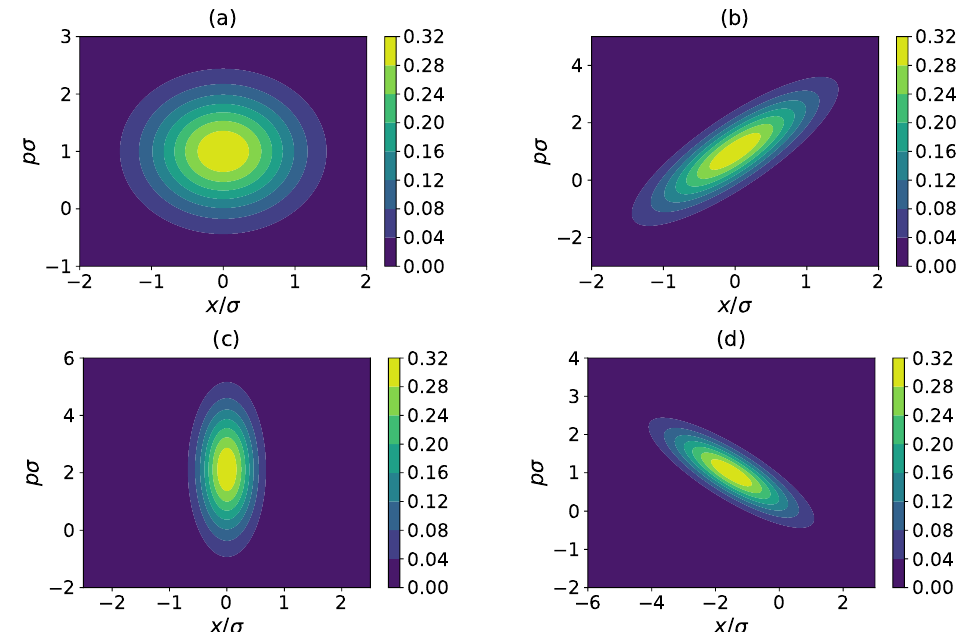
Figure 1: Contour plots of different Wigner functions. Panel (a) shows the Wigner function W ( x , p ) for a Gaussian wave packet, see Eq. (18). In the x and p direction, W ( x , p ) is a Gaussian centered around the phase space point ( a , k ) with variance σ 2 / 2 and ( 2 σ 2 ) − 1 , respectively. We chose a = 0, k = 1, and σ = 1. Panel (b) shows the Wigner function W + ( x , p ) for the wave function | ψ + 〉 ≡ exp ( ξ + ˆ S + ) | ψ 〉 , see Eq. (82). This transformation shifts the p variable by an x -dependent linear term, i.e., p → p − x Im ( ξ + ) ; here we choose ξ + = 1.5 i . Panel (c) shows the Wigner ( x , p ) for the wave function | ψ 〉 ≡ exp ( ξ z ˆ S z ) | ψ 〉 , see Eq. (77). This function W z transformation uniformly rescales the variables ( x , p ) to ( x e ξ z / 2 , p e − ξ z / 2 ) ; here we chose ξ z = 1.5. Panel (d) shows the Wigner function W − ( x , p ) for the wave function | ψ 〉 ≡ exp ( ξ − ˆ S − ) | ψ 〉 , see Eq. (71). This transformation shifts the x variable by a p -dependent linear term according to x → x + p Im ( ξ − ) ; we chose ξ − = 1.5 i